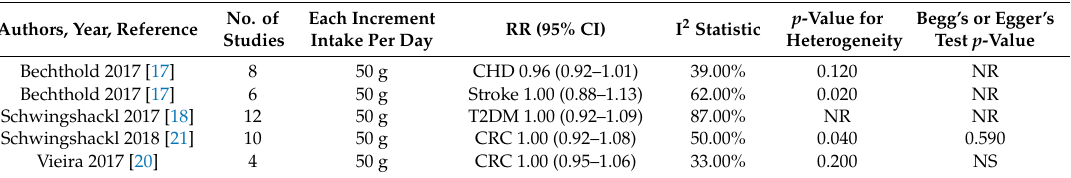
Table 10. Summary of linear dose-response meta-analyses of prospective studies on legume intake and CHD, stroke, T2DM, CRC.